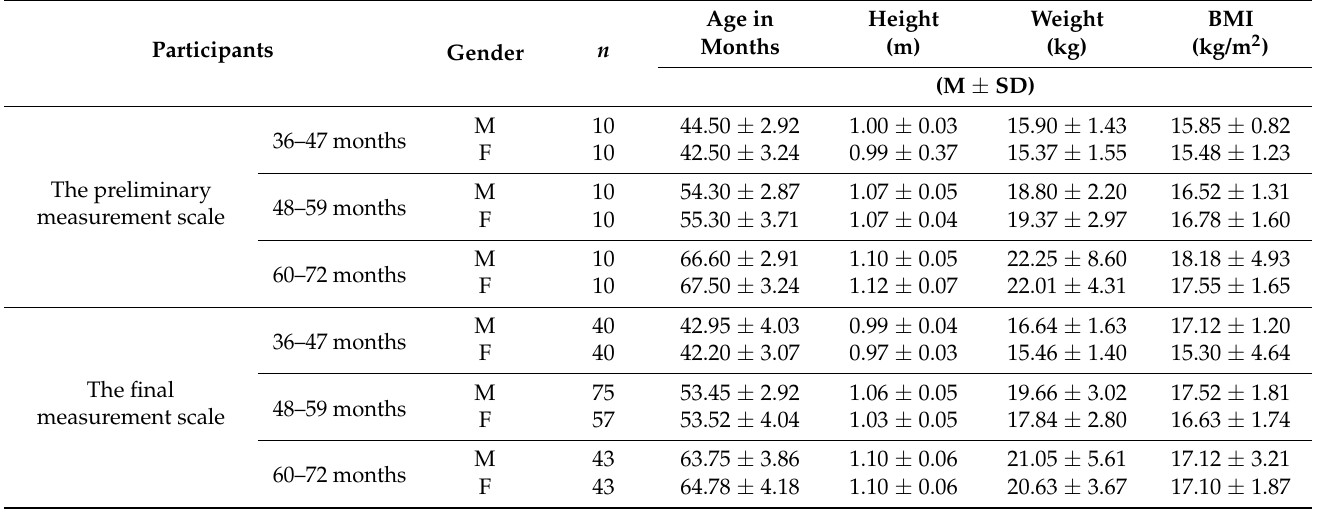
Table 1. Participants in developing the preliminary and final measurement